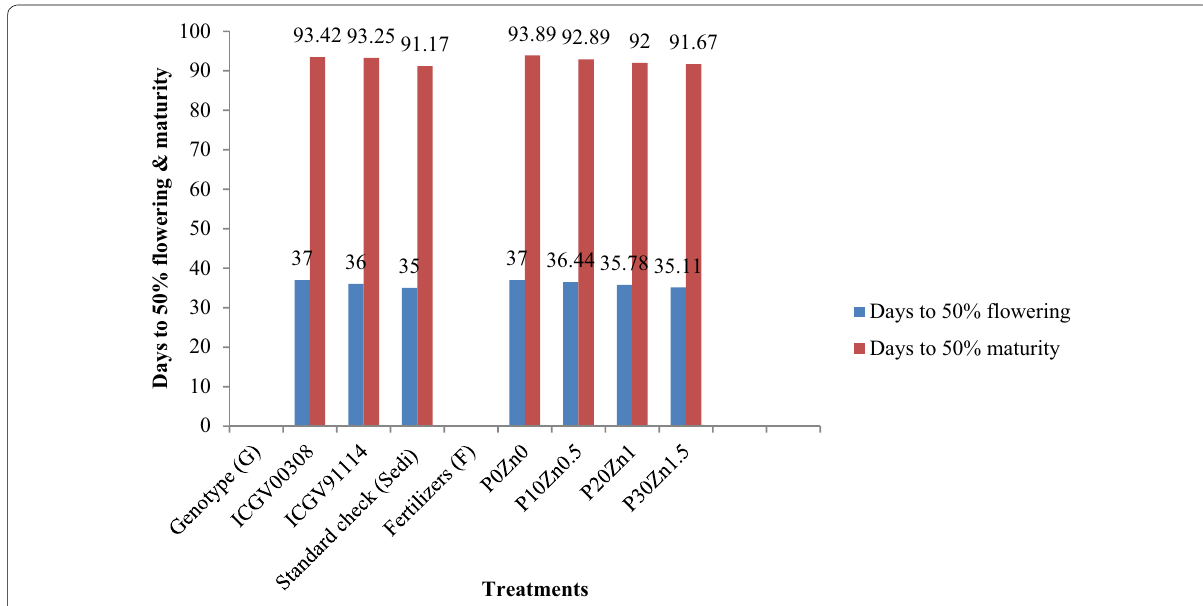
Fig. 1 Effect of groundnut genotypes and PZn fertilizer on Phenology of